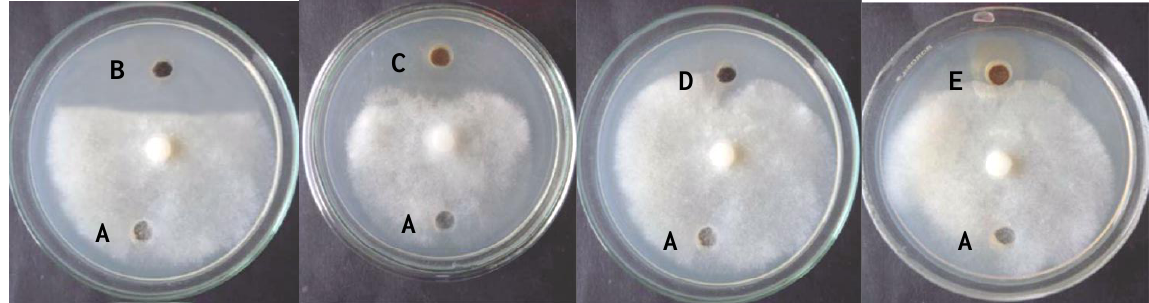
Figure 6. Inhibition of mycelial growth of P. aphanidermatum . ( A ) Control containing sterile distal H 2 O; ( B ) control containing Metalaxyl; ( C ) treated containing nano-metal complex (20 ppm); ( D ) treated containing nano-metal complex (15 ppm), and ( E ) treated containing nano-metal complex (10 ppm) on PDA at 26 °C for 6 days in the dark. Table 5. Antifungal activity of nano-metal complex against P. aphanidermatum on PDA medium at 26 °C for 6 days in the dark.